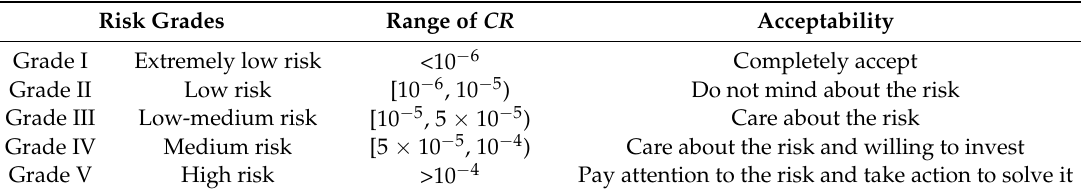
Table 2. Levels and values of assessment